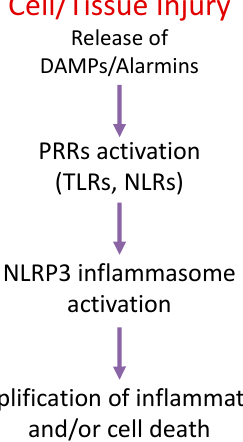
Figure 1. Schematic representation of the critical steps that lead from cellular injury to the inflammatory response. DAMPs, damage associated molecular patterns; PRRs, pattern recognition receptors; TLRs, Toll-like receptors; NLRs, Nod-like receptors; NLRP3, NACHT, leucine-rich repeat (LRR), and pyrin domain (PYD)-containing protein 3.